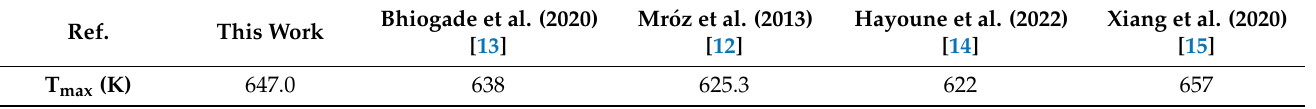
Table 7. Peak temperatures for the PLA pyrolysis at 10 K/min.